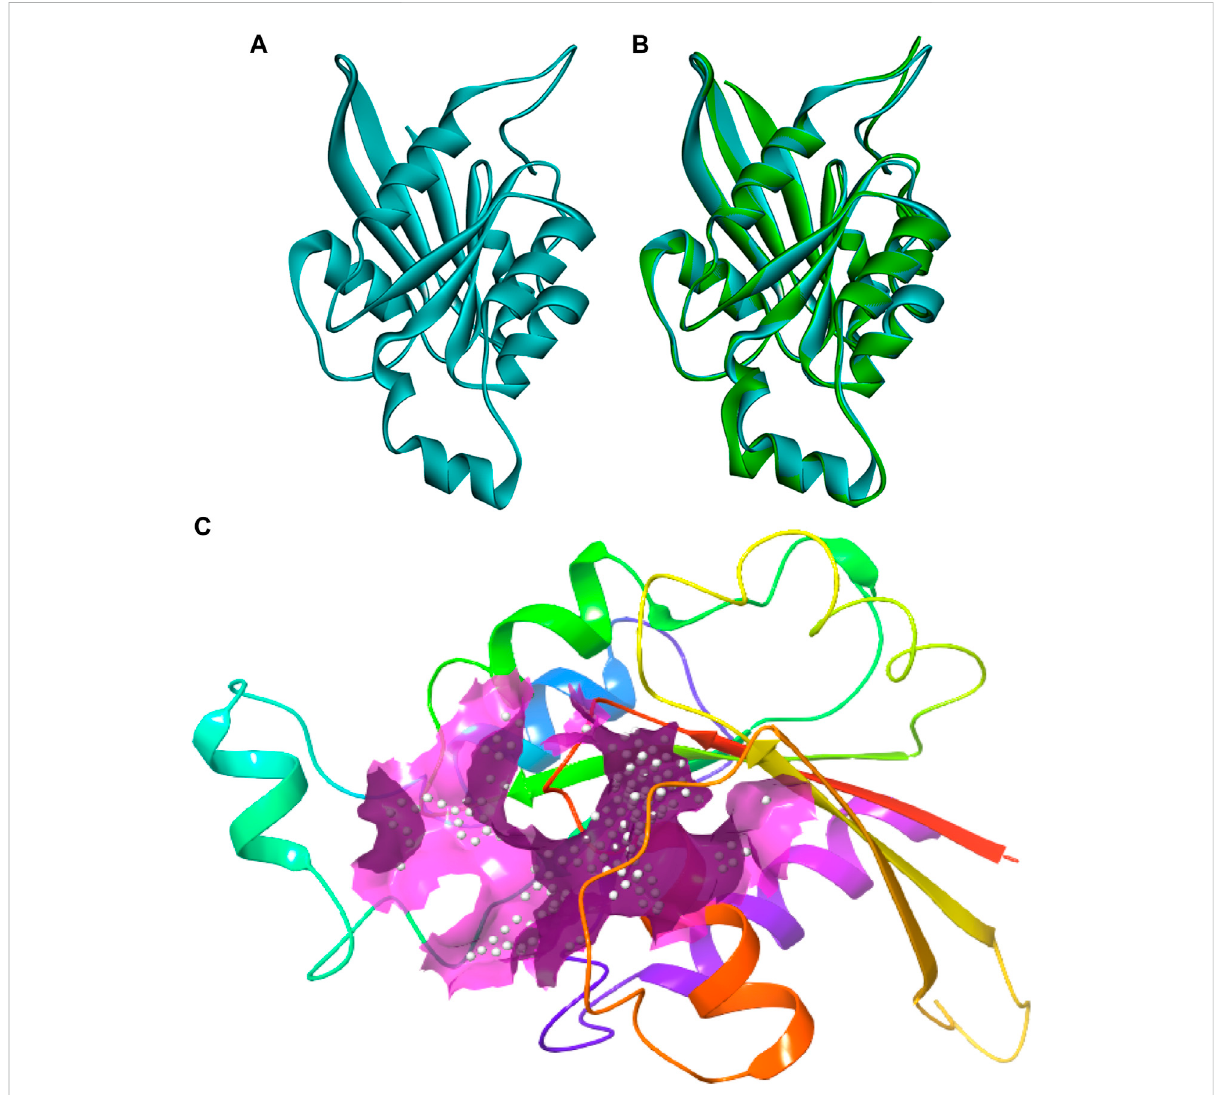
FIGURE 1 Three-dimensional structure of CDC42 predicted through homology modeling (B) The structure of CDC42 protein superimposed with the template (2NGR) structure. (C) Binding site prediction representing the active site region